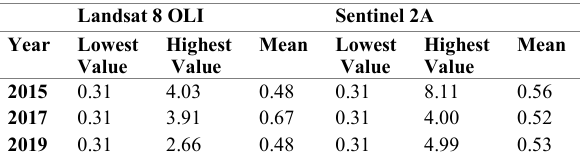
Table 8: LAI Value Ranges for Landsat 8 and Sentinel 2A